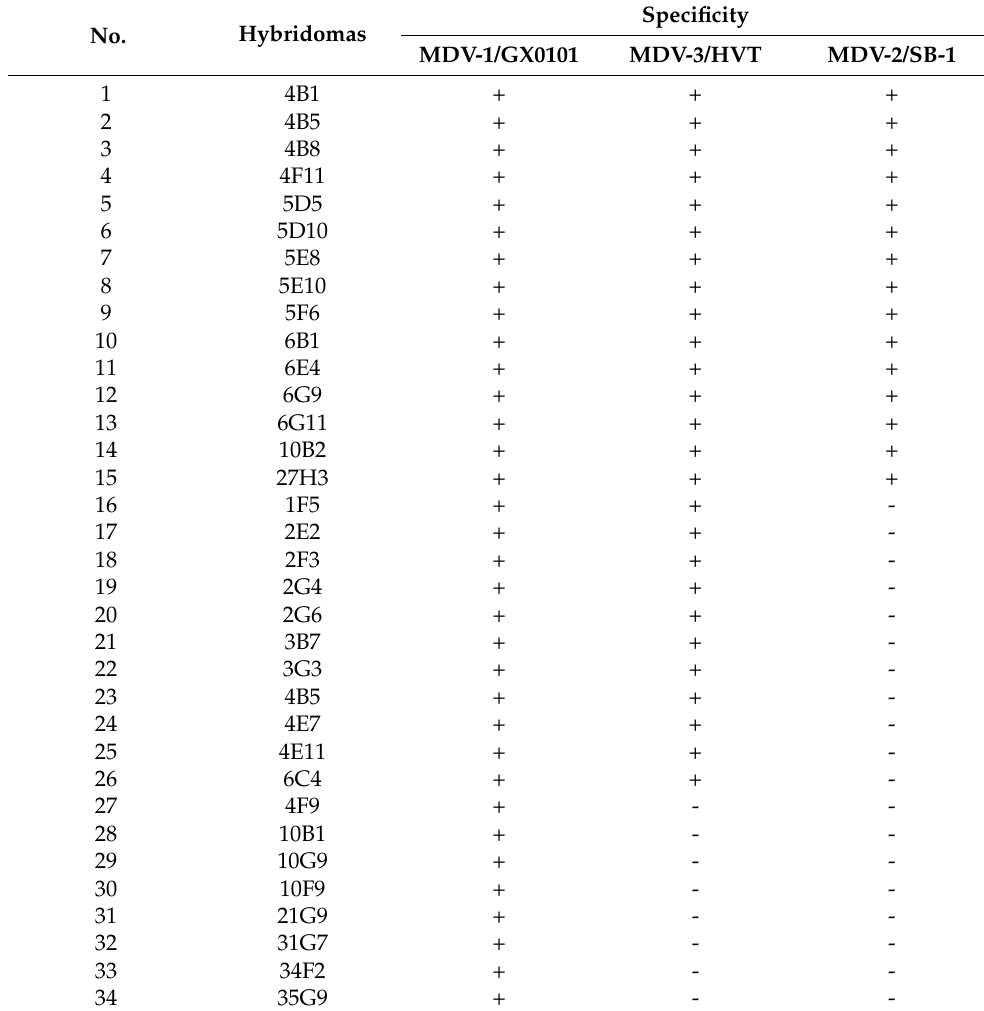
Table 3. List of the hybridomas secreting MDV-specific monoclonal antibodies.